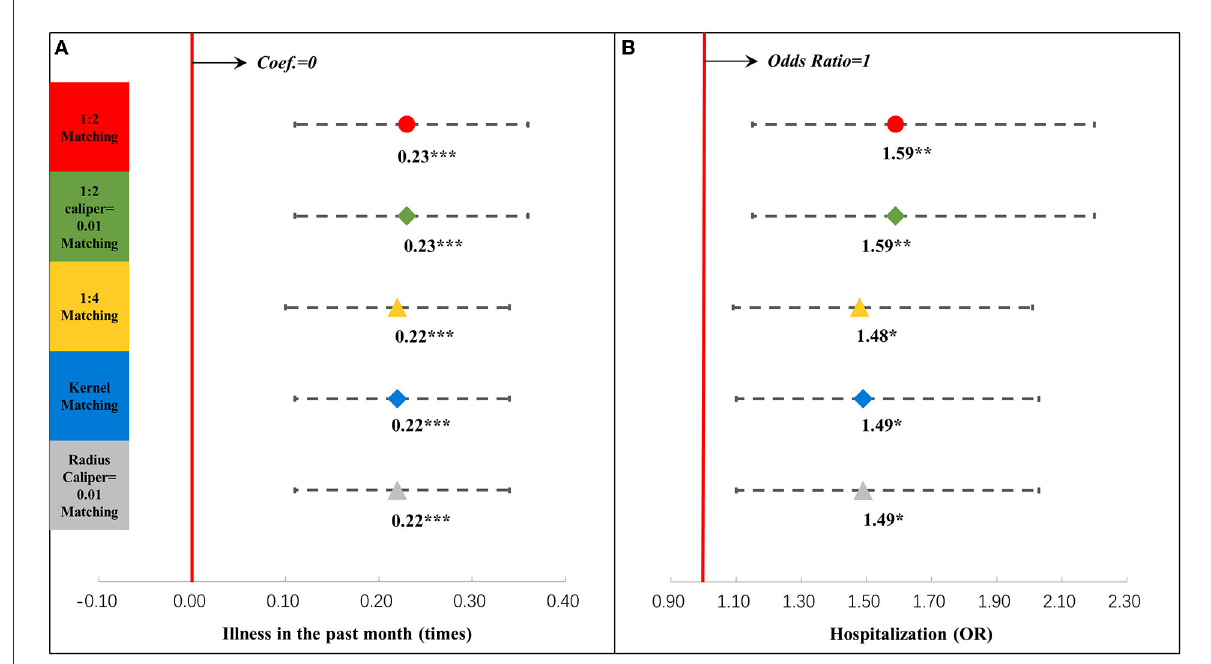
FIGURE7 Results of regression analysis of illness in the last month (A) and hospitalization (B) after propensity score matching. * P < 0.05, ** P < 0.01, *** P < 0.001. The results of different propensity score matching analyses are shown too. Dots and lines represent means and 95% confidence intervals for Coef. or ORs estimated from generalized linear mixed regression analyses. Maternal, family, and infant characteristics were also included in the regression analyses but are not reported. Details are reported in Supplementary Table